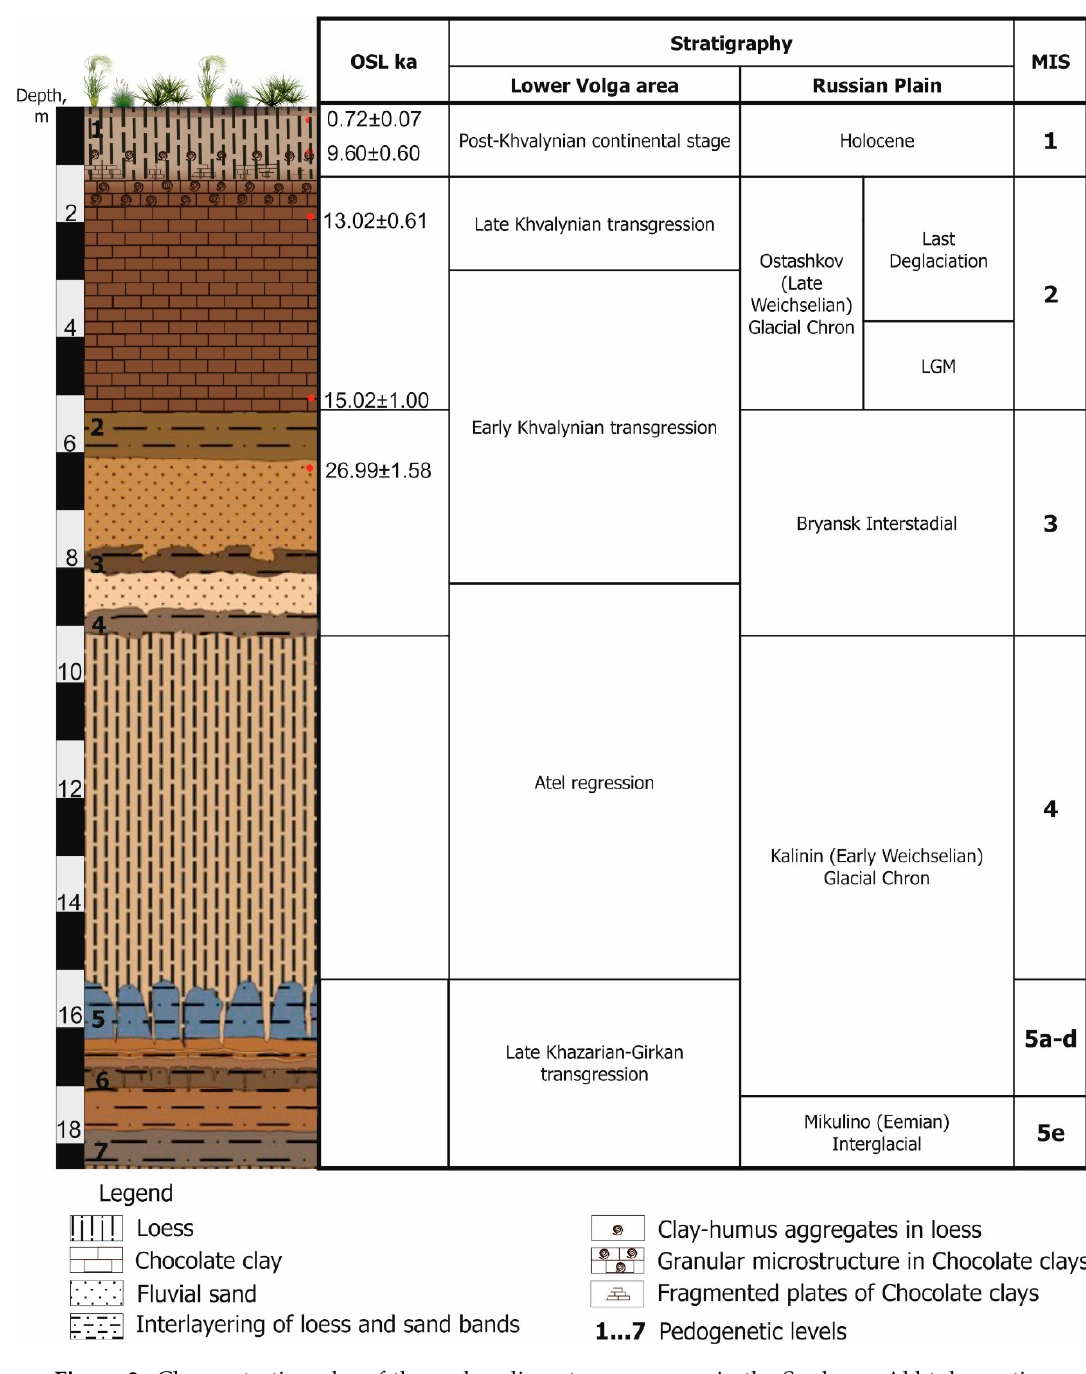
Figure 2. Chronostratigraphy of the pedosedimentary sequence in the Srednaya Akhtuba section. The